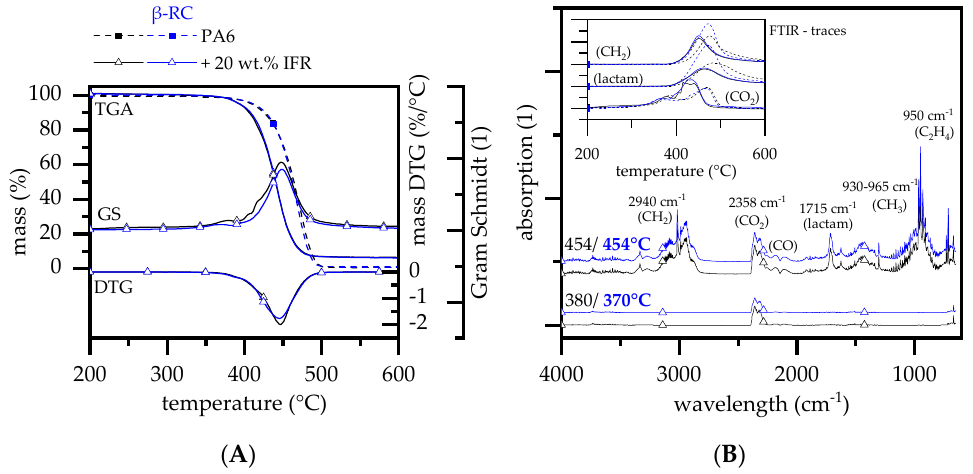
Figure 6. TGA, DTG, Gram Schmidt and FTIR (Gas) curves determined at a heating rate of 20 K/min. ( A ) TGA, DTG Gram Schmidt for PA6 containing 20 wt.% IFR; ( B ) corresponding FTIR peak spectra.